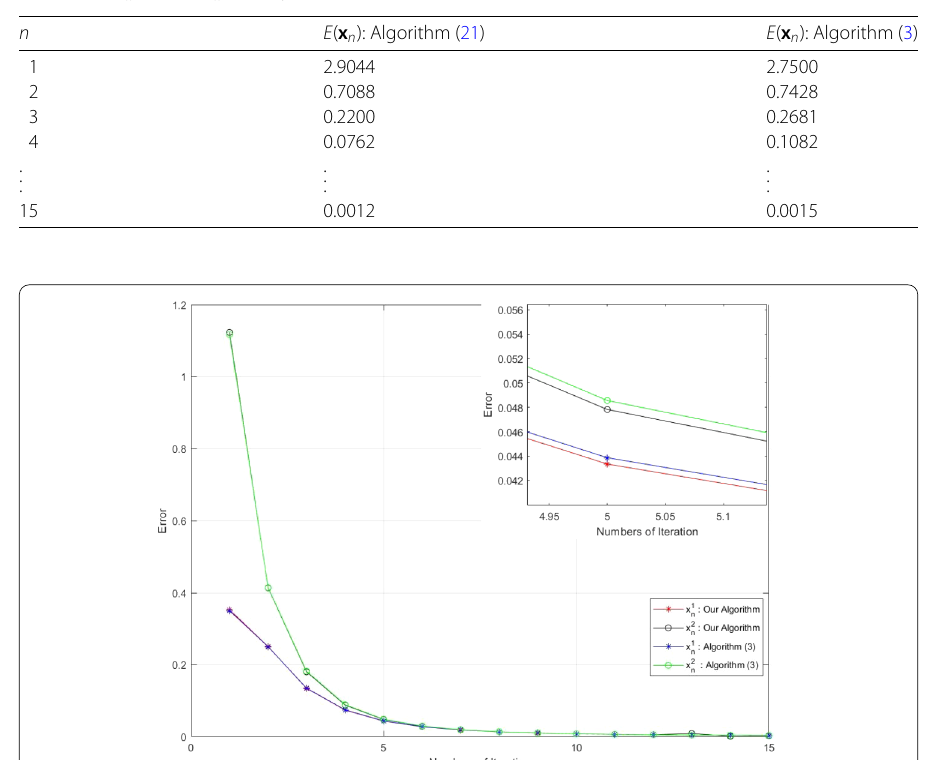
Figure 1 Comparison between Algorithms (21) and (3) for Example 1 with u = (5,5) and N =